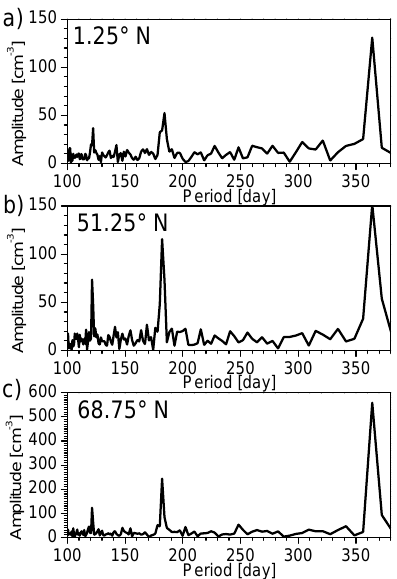
Figure 9. Results of an FFT (fast Fourier transform) analysis of the OH ∗ density in height of the peak at 1.25 ◦ N (a) , 51.25 ◦ N (b) , and 68.75 ◦ N (c) latitude using the whole period of 49